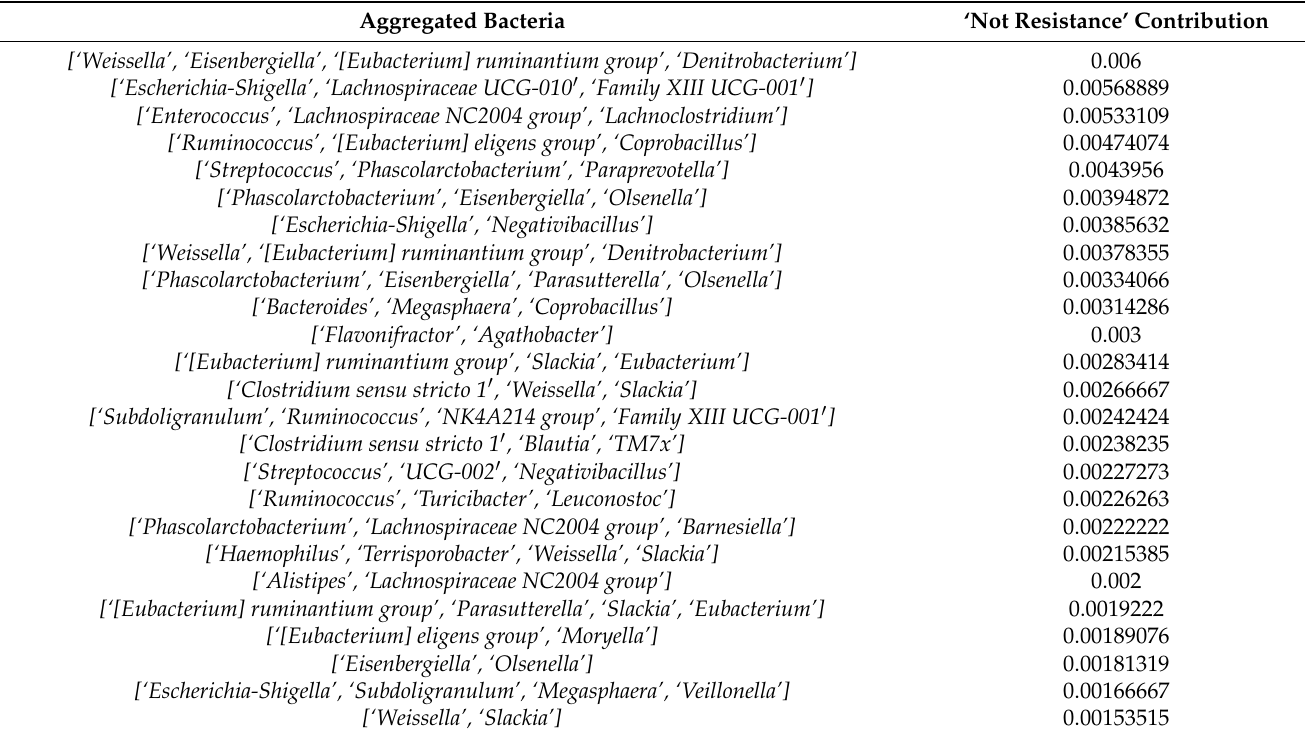
Table 5. Aggregated bacteria significance contributions to the not resistant class. Aggregated